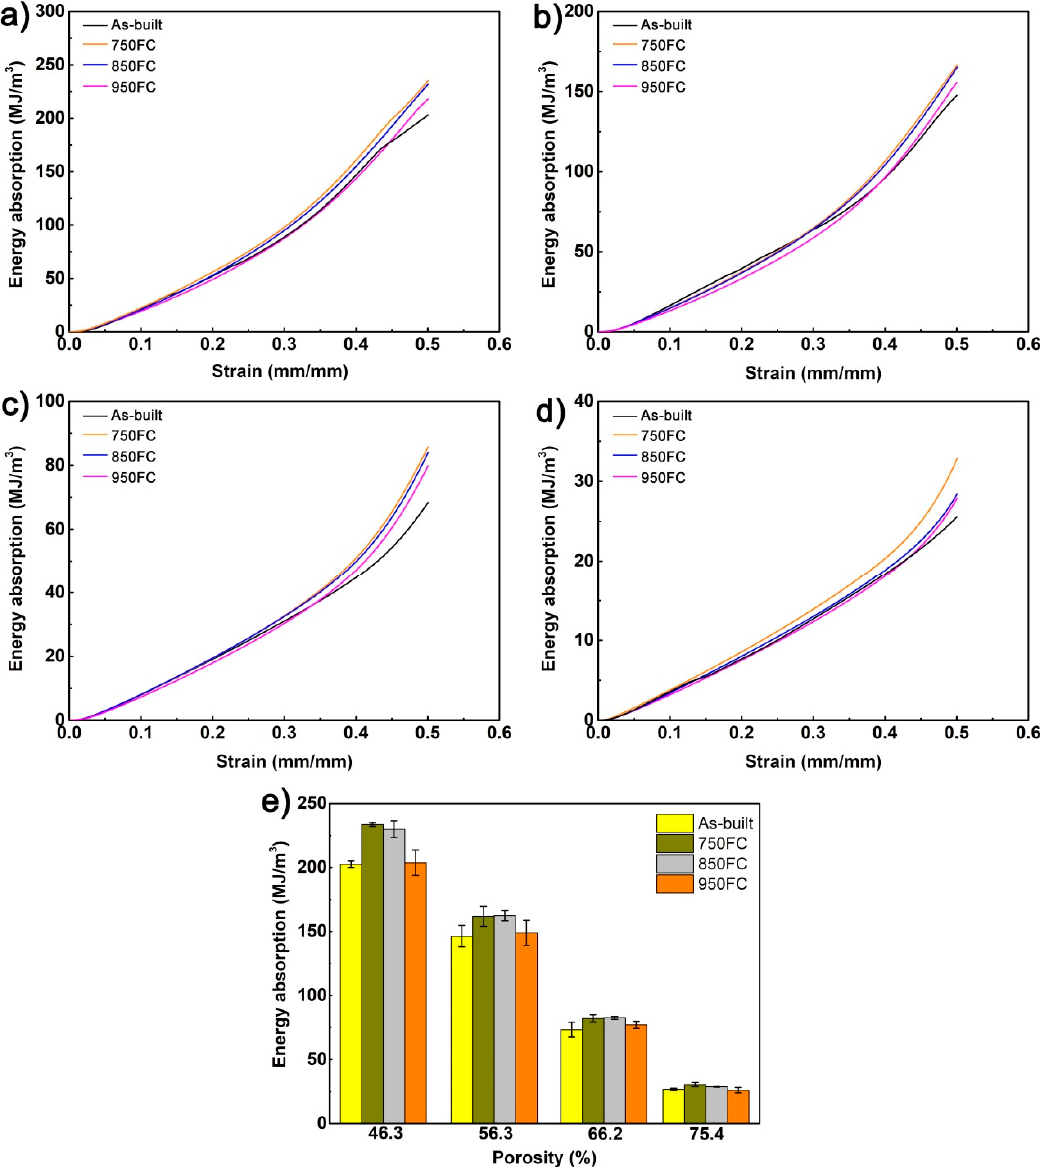
Figure 12. The energy absorptions of porous Ti64 structures with different porosities before and after different heat treatments: ( a ) 46.3%; ( b ) 56.3%; ( c ) 66.2%; ( d ) 75.4%; ( e ) energy absorption at ε = 50%.